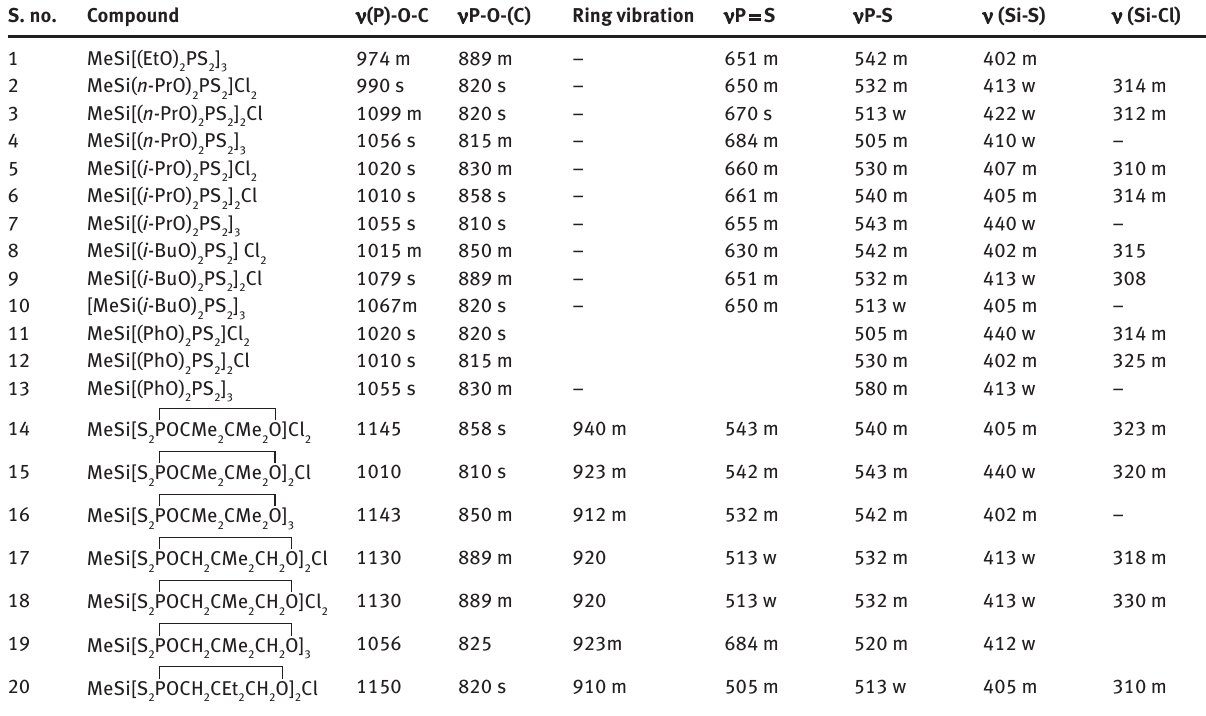
Table 2: IR spectroscopic data (cm − 1 ) of methylsilicon (dialkyl and alkylenedithiophosphate) derivatives. S.